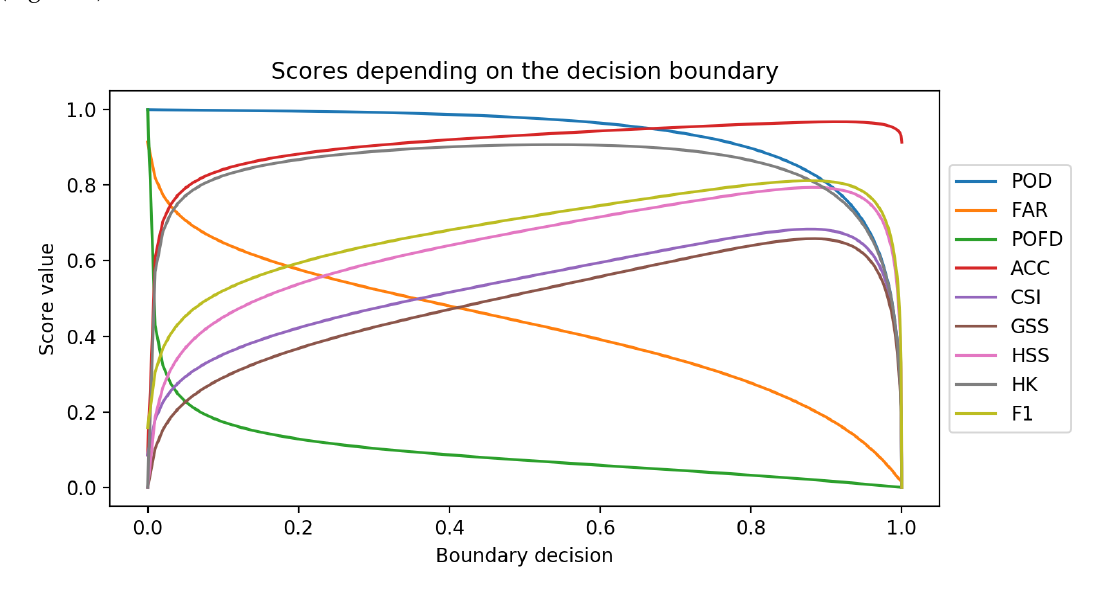
Figure 9. Classification scores vs boundary decision for the satellite and gauges model, computed on the training and validation